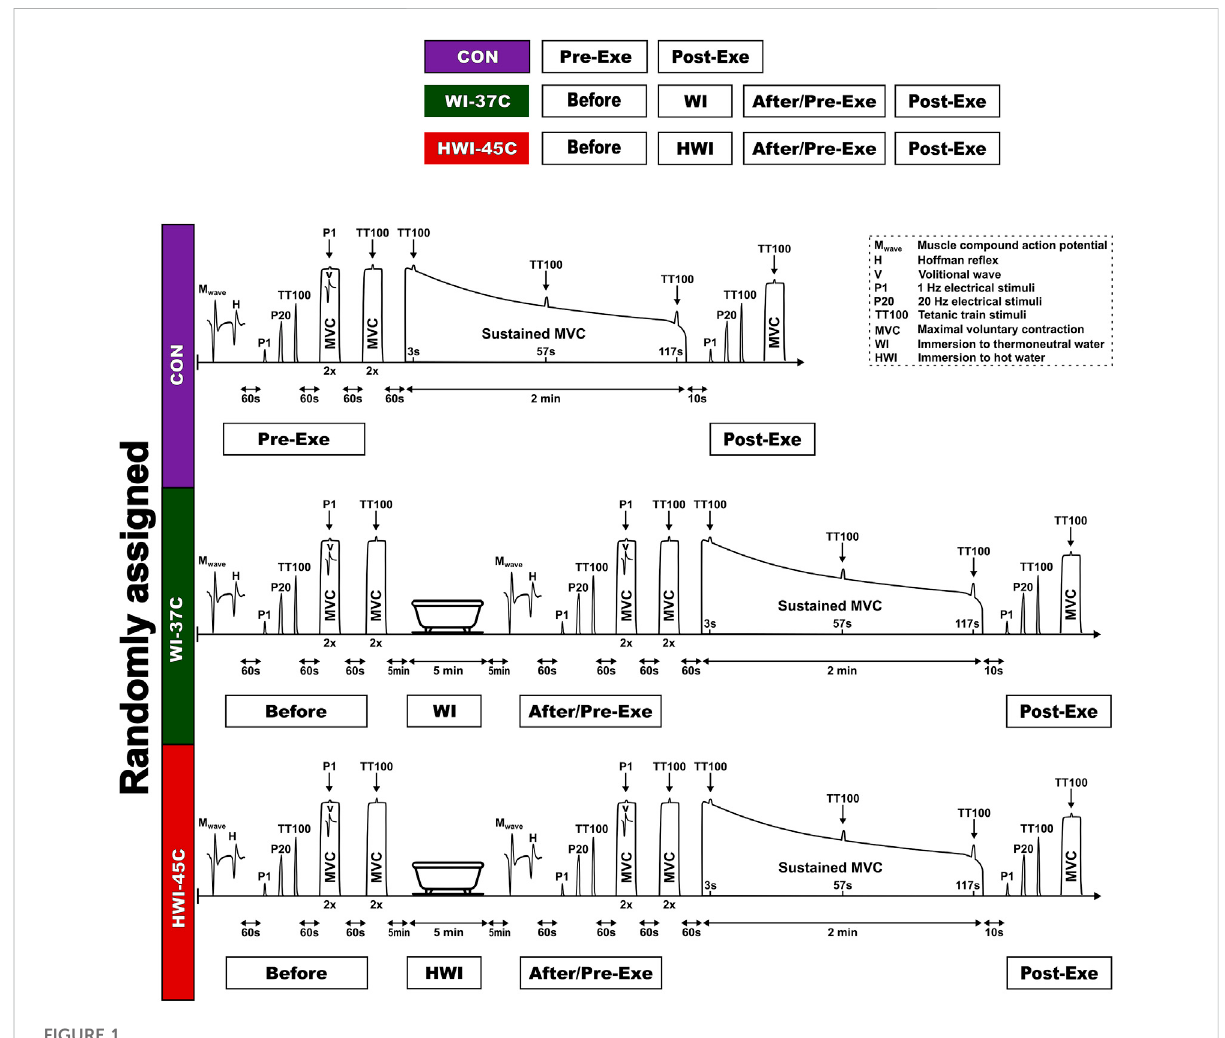
FIGURE 1 Schematic representation of the experimental